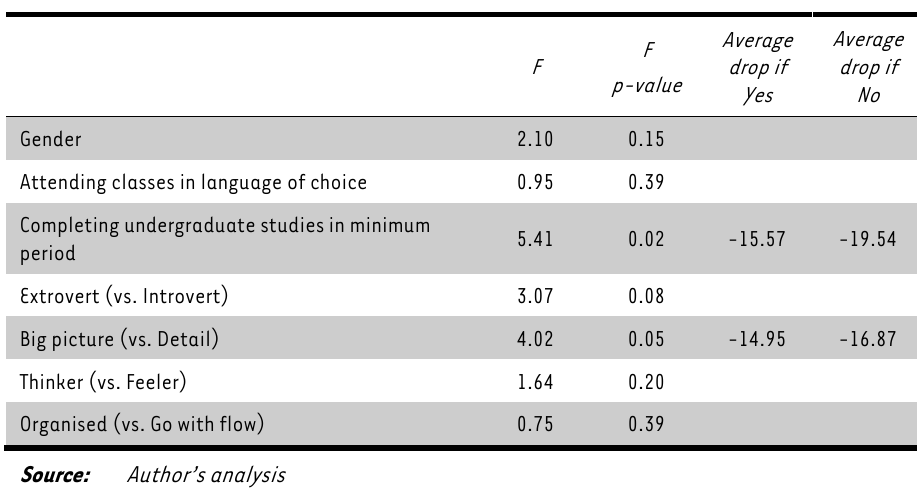
Average Average F drop if F drop if p-value No Yes